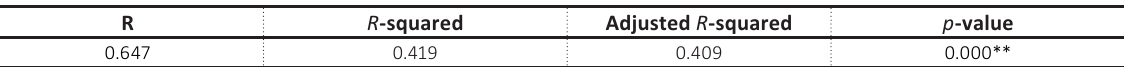
Table 10. Summary of adjusted R -squared